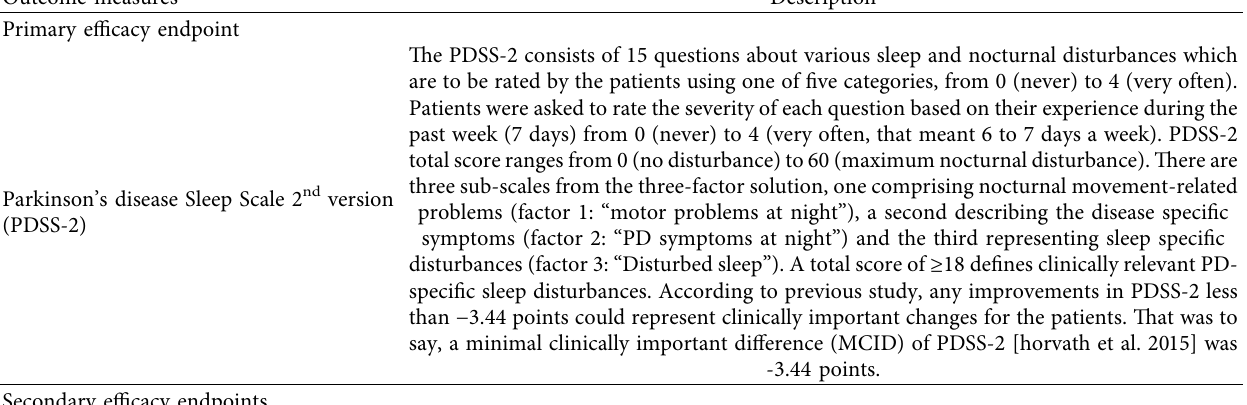
Table 1: Description of outcome measures for primary and secondary efficacy